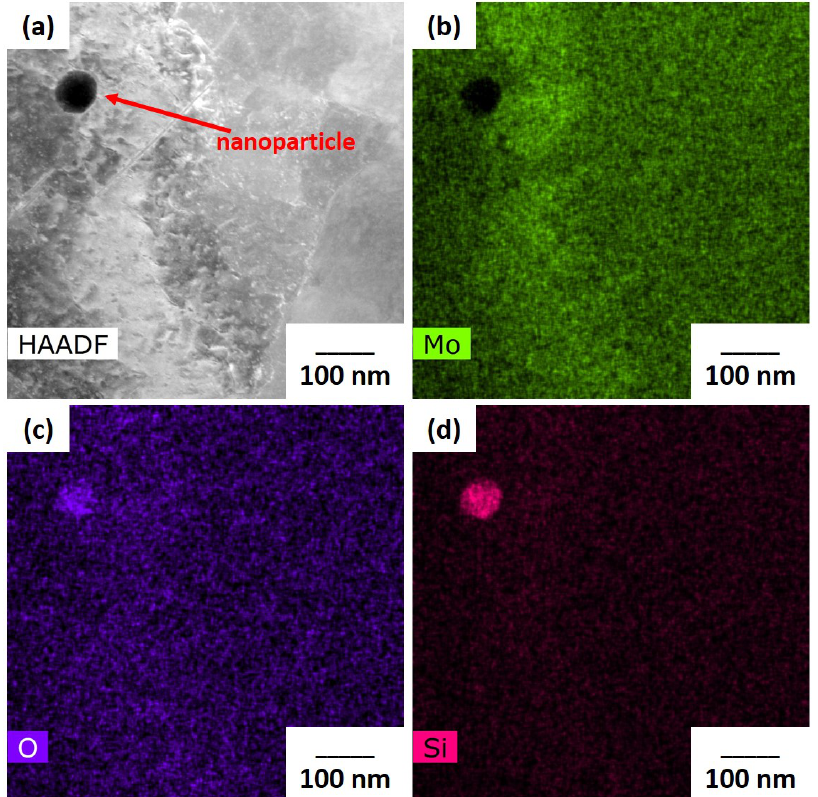
Figure 6. EDS analysis of the nanoparticles conducted via TEM. ( a ) High-angle annular dark field (HAADF) image. ( b ) EDS map with molybdenum highlighted. ( c ) EDS map with oxygen highlighted. ( d ) EDS map with silicon highlighted.